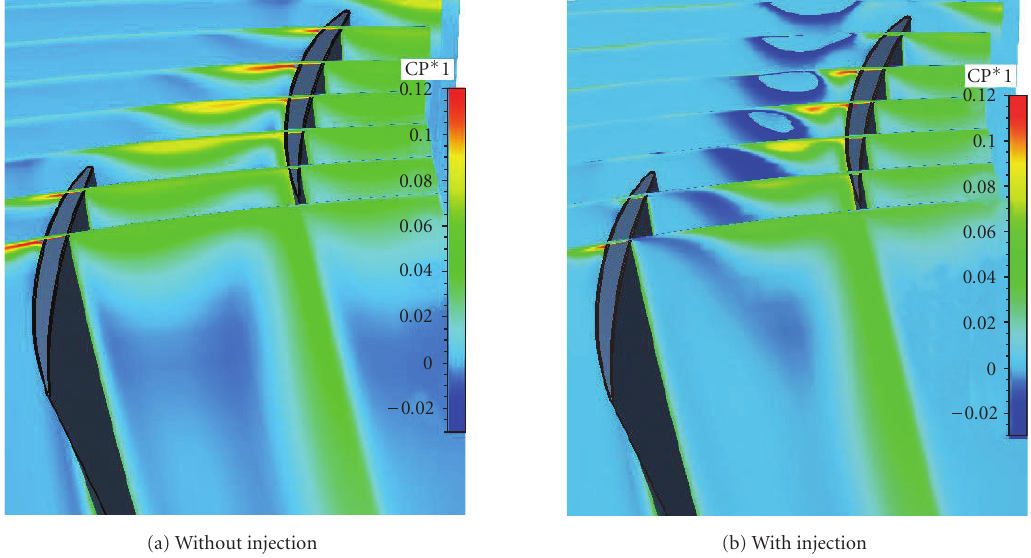
Figure 14: Total pressure loss coe ffi cient distributions on cross-flow planes for smoothwall stall mass flow